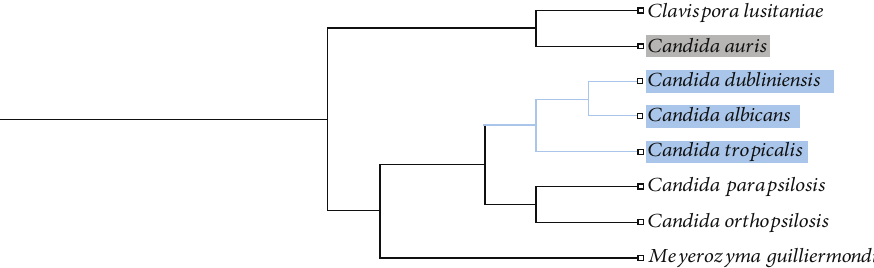
Figure 1: Phylogenetic tree of selected species of the CTG clade generated on the basis of the NCBI or GTD taxonomy available in the online version of the phyloT program.